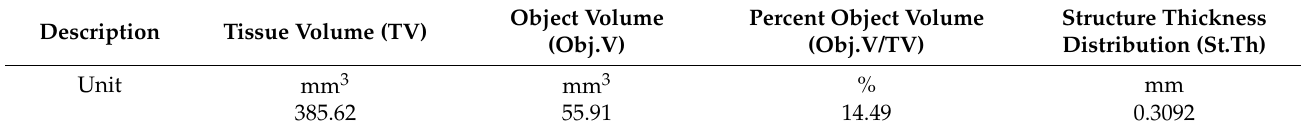
Table 4. Quantitative calculation of adipose tissue volume.